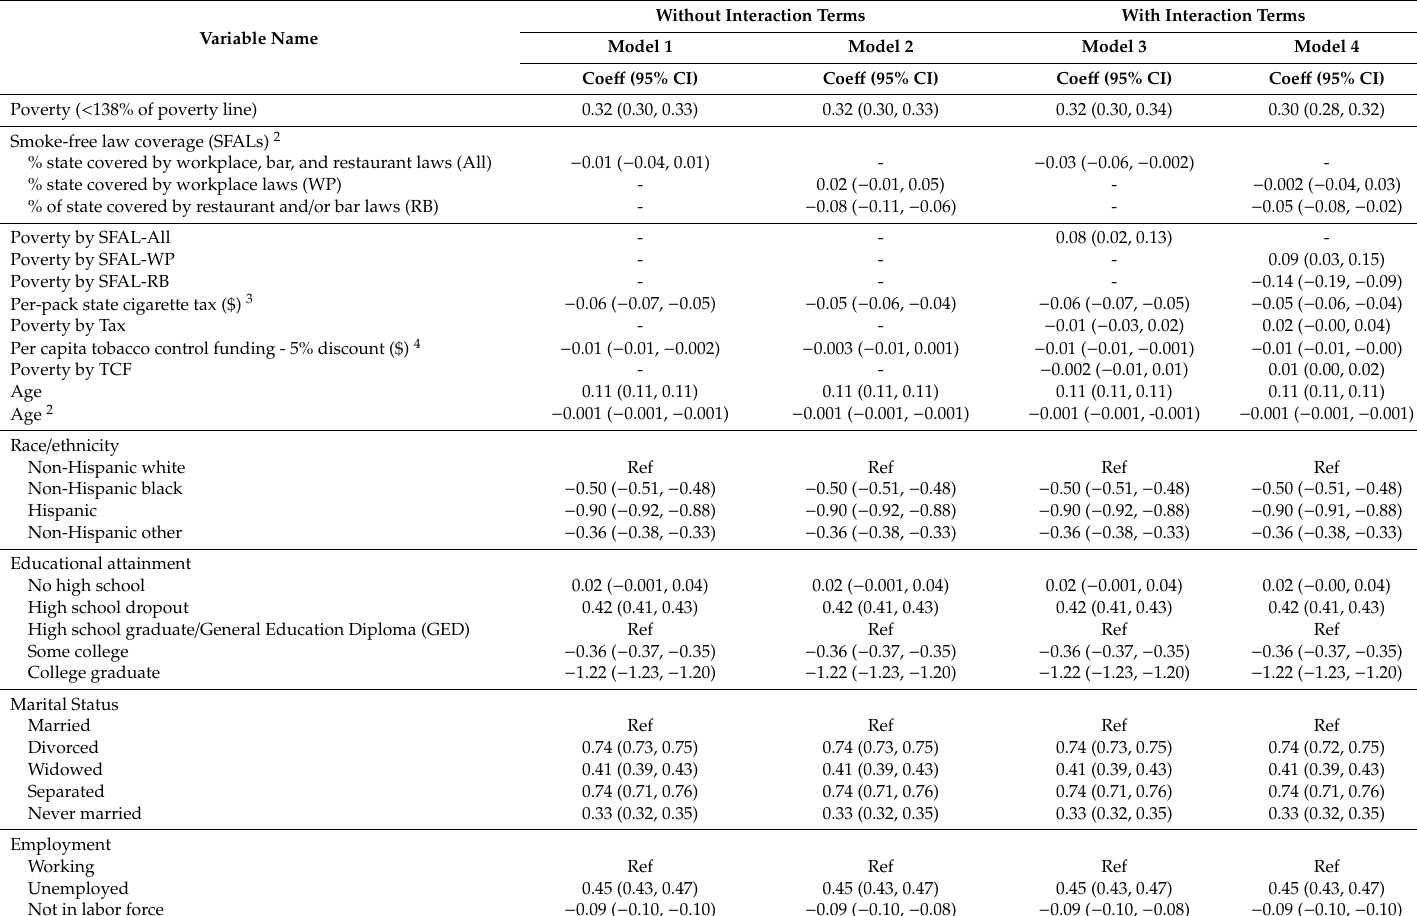
Table 2. Multivariable logistic regression models of current prevalence of cigarette smoking regressed on poverty status 1 and tobacco control policies with and without interaction terms for poverty and tobacco control policies, using data from supplements to the U.S. Census Current Population Survey